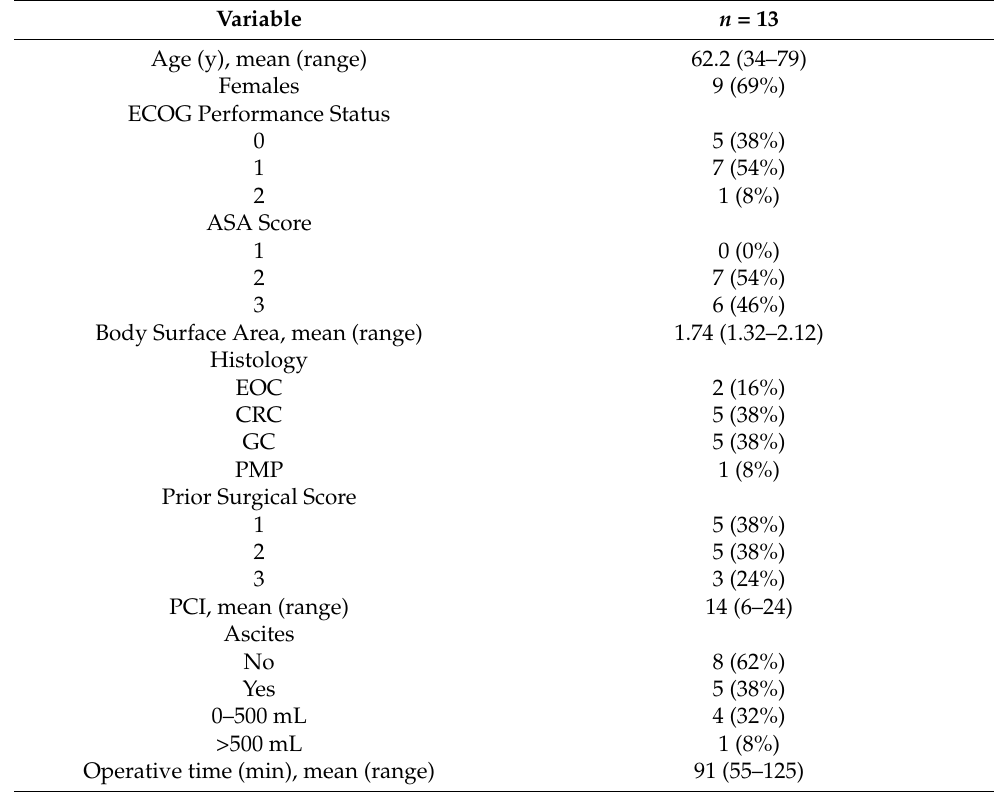
Table 1. Demographic clinical and perioperative features of